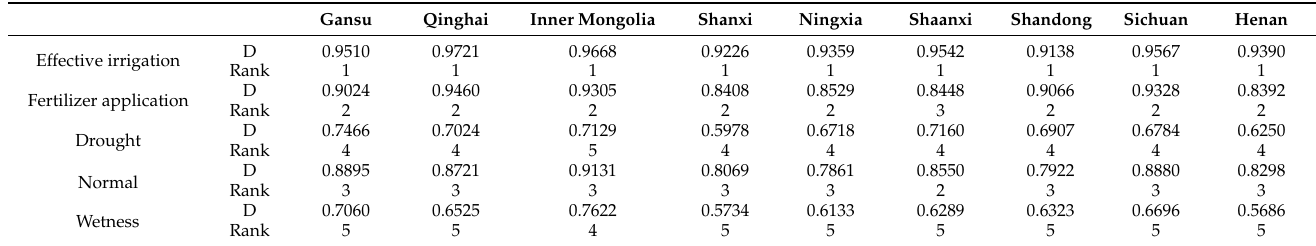
Table 5. Grey correlation degree between grain yield per unit area and related influencing factors in Yellow River basin from 1979 to 1998.